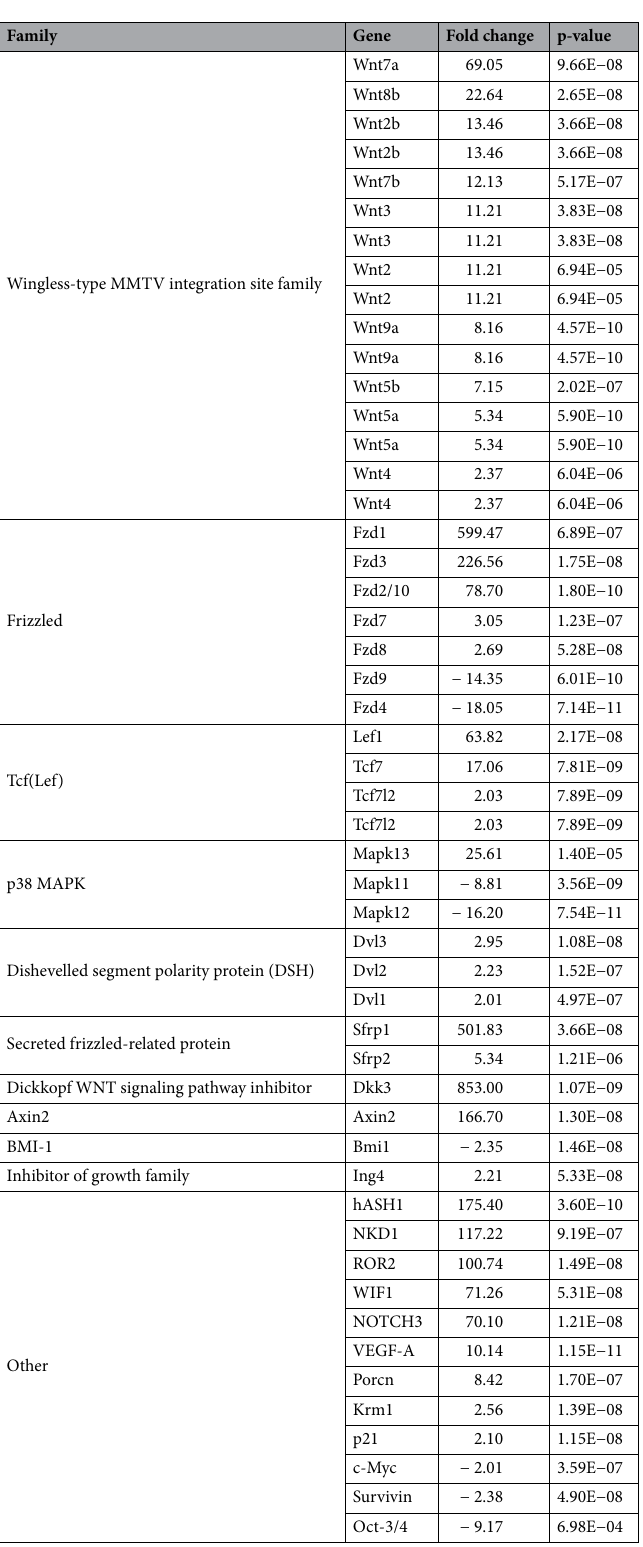
Table 2. Differentially expressed genes involved in the WNT signaling pathway. List of transcripts DEG in the WNT pathway sorted by family/function, and its respective fold change and p-value when compared PVEC vs.